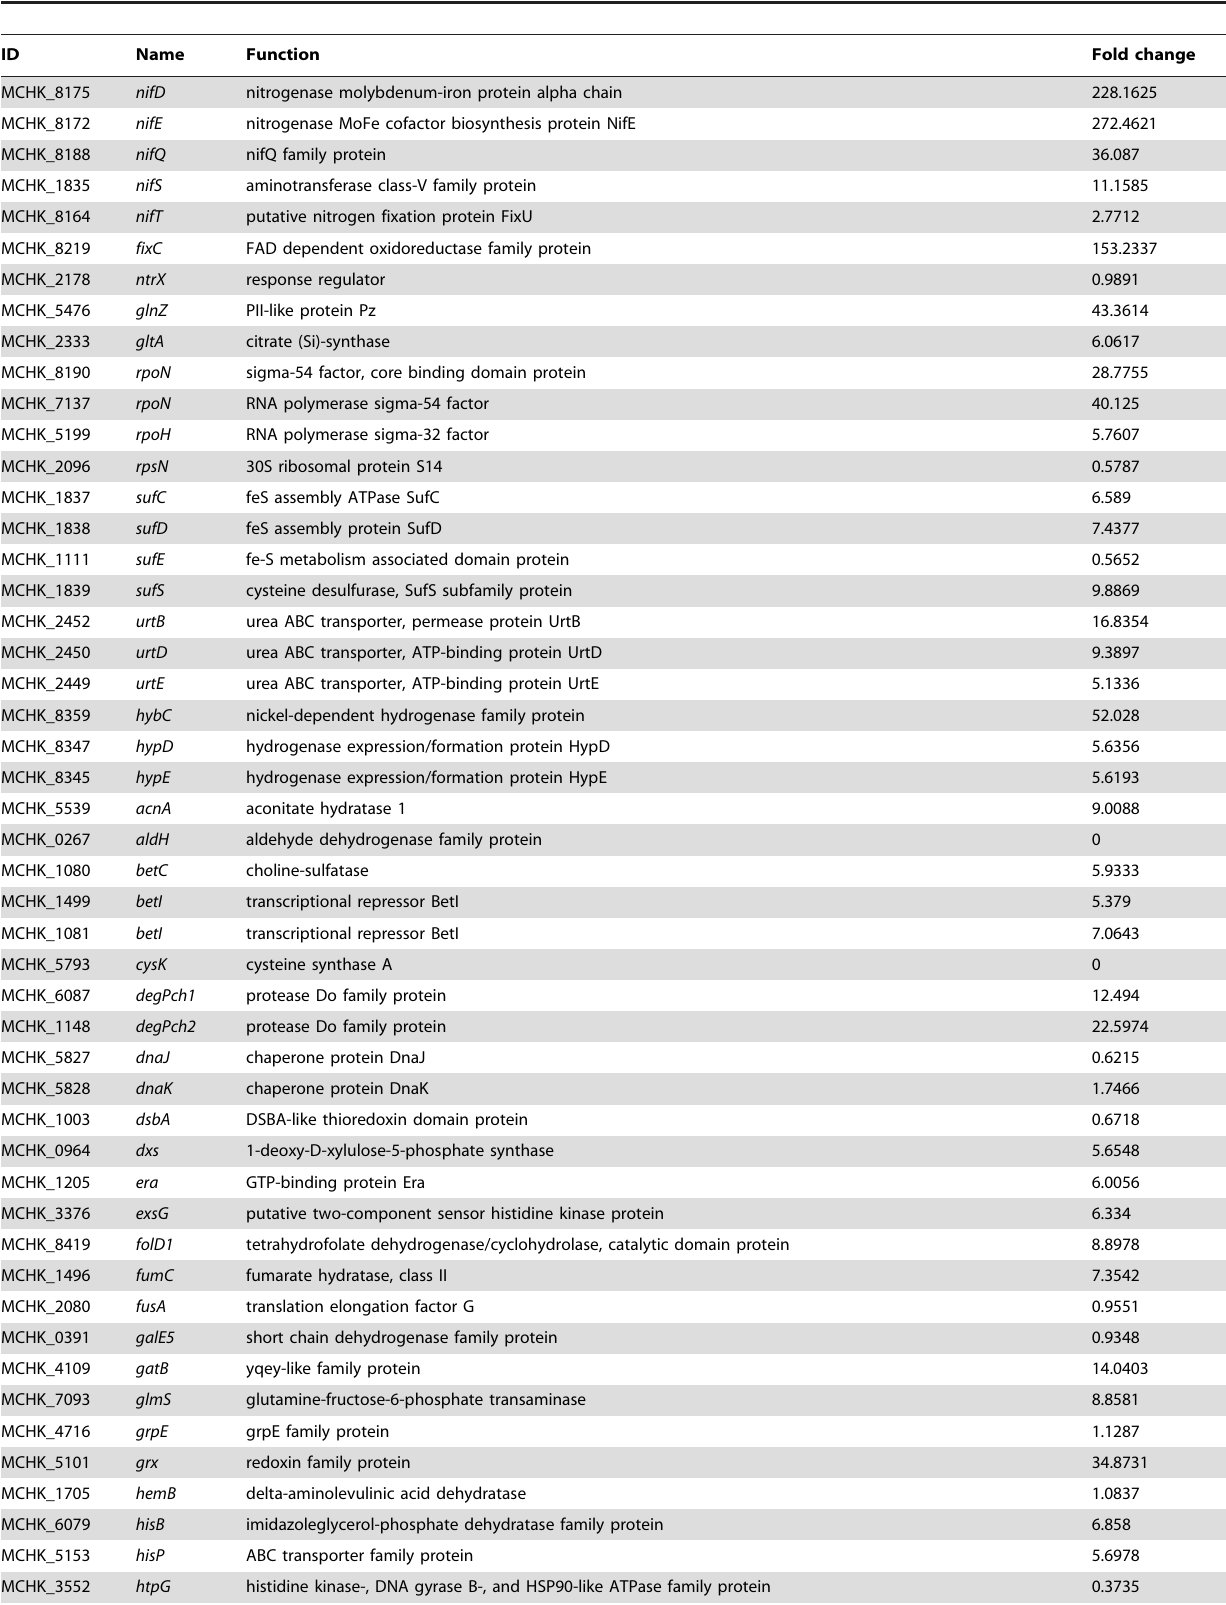
Table 3. The set of genes in the M. huakuii 7653R subnetwork of nitrogen fixation.